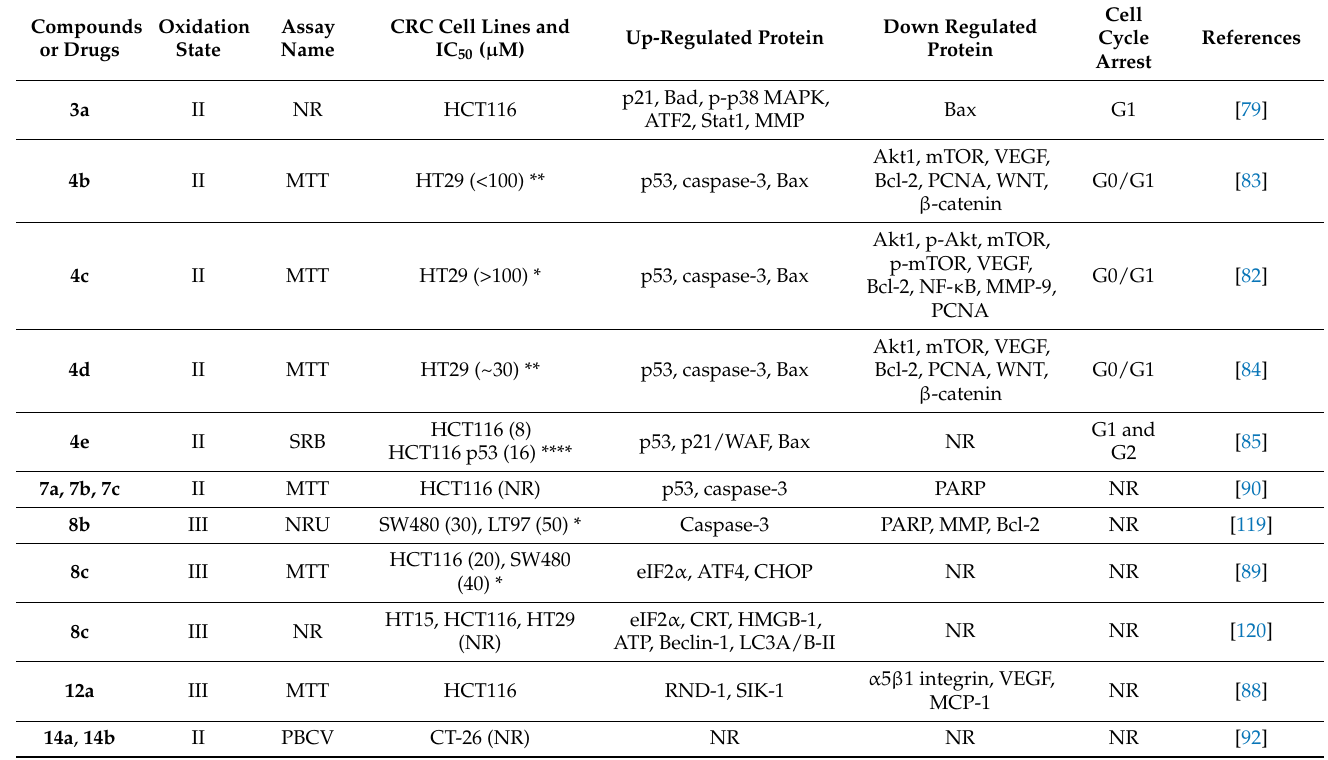
Table 2. Cytotoxic potential of some Ru-complexes towards CRC